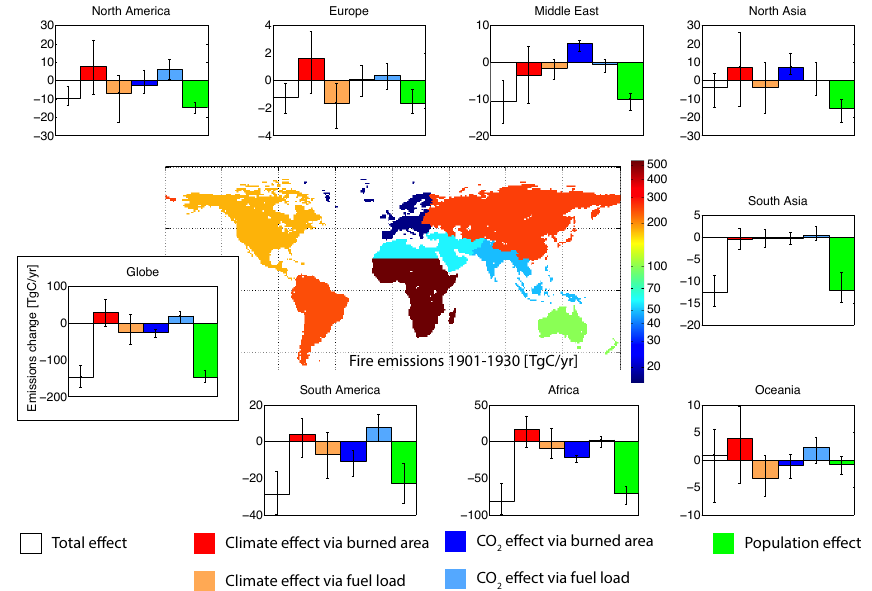
Figure 4. Regional wildfire emissions during 1901–1930 for eight regions and global and regional changes, average 1971–2000 minus average 1901–1930, for ensemble mean (white/coloured bars) and range across ensemble comprising eight ESMs (error bars), in TgCyr − 1 . The change in emissions is further subdivided into climate effect due to changes in burned area or changes in combusted fuel per burned area, effect of atmospheric CO 2 change due to changed burned area or fuel combustion, and population